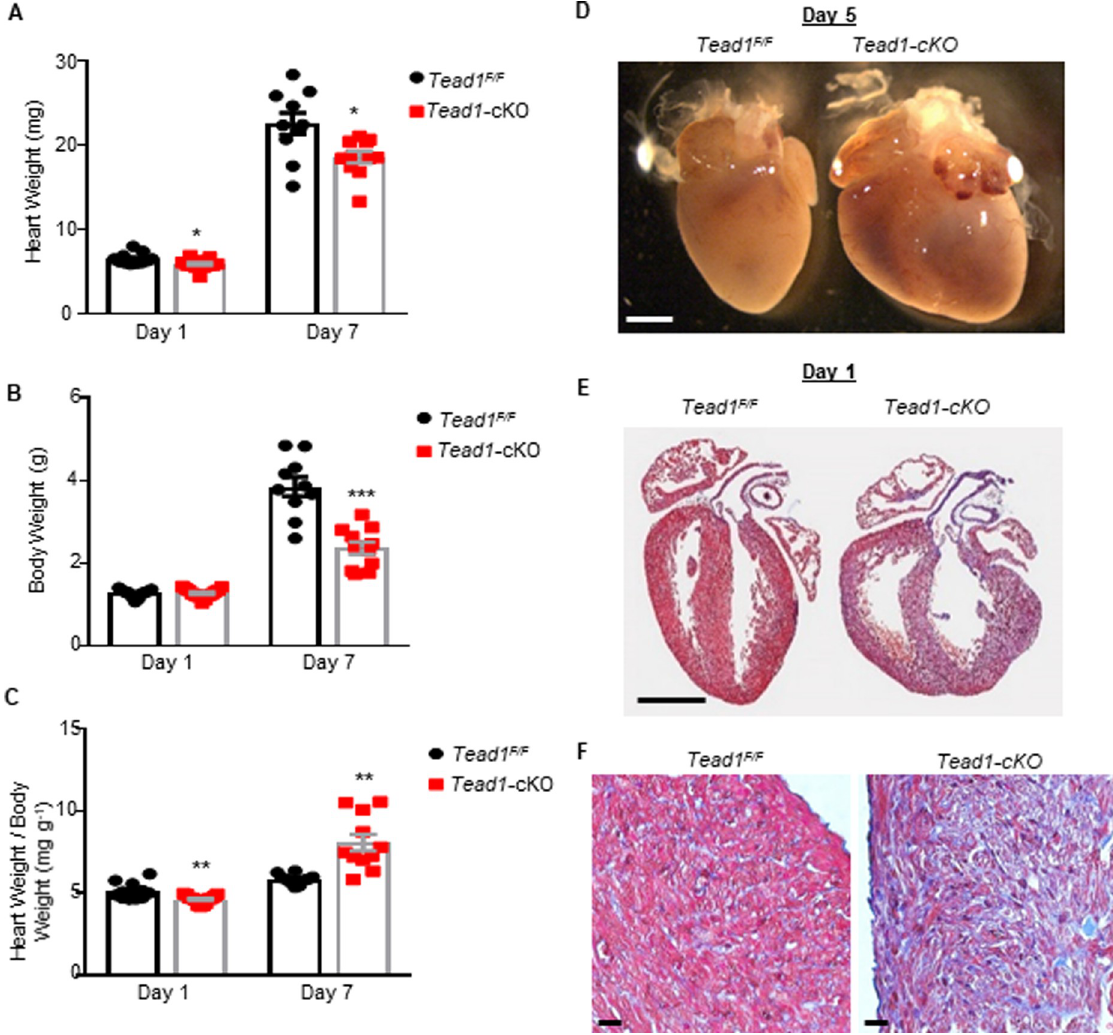
Fig 3. Tead1 loss-of-function results in heart failure associated with myocardium hypoplasia. ( A ) Heart weight ( B ) Body weight and ( C ) heart weight to body weight ratios of Tead1-cKO mice at postnatal days 1 and 7 (n = 10–13). ��� p < 0.001, �� p < 0.01; Student’s t -test. ( D ) Tead F/F and Tead1 -cKO postnatal days 5 hearts. Scale bar, 1mm. ( E-F ) Representative coronal section Trichrome staining of day-1 Tead F/F and Tead1 -cKO mice hearts. Scale bar, 1mm ( E ), 20 μ m ( F ).